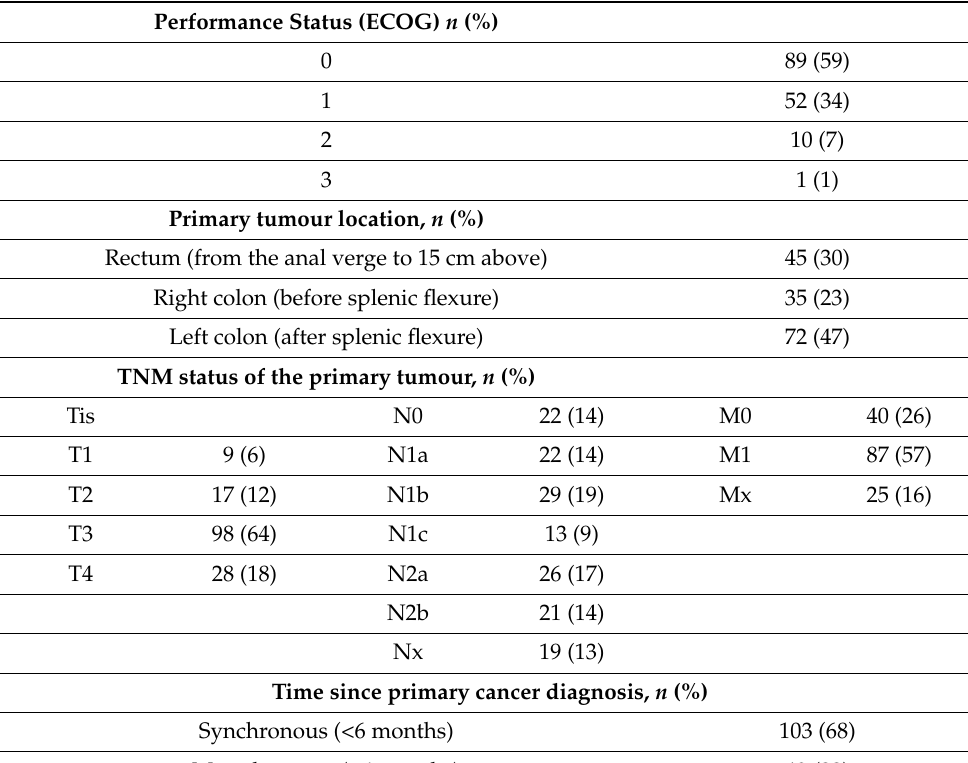
Table 1. Baseline, primary tumour and liver metastases characteristics. Data is presented as counts and